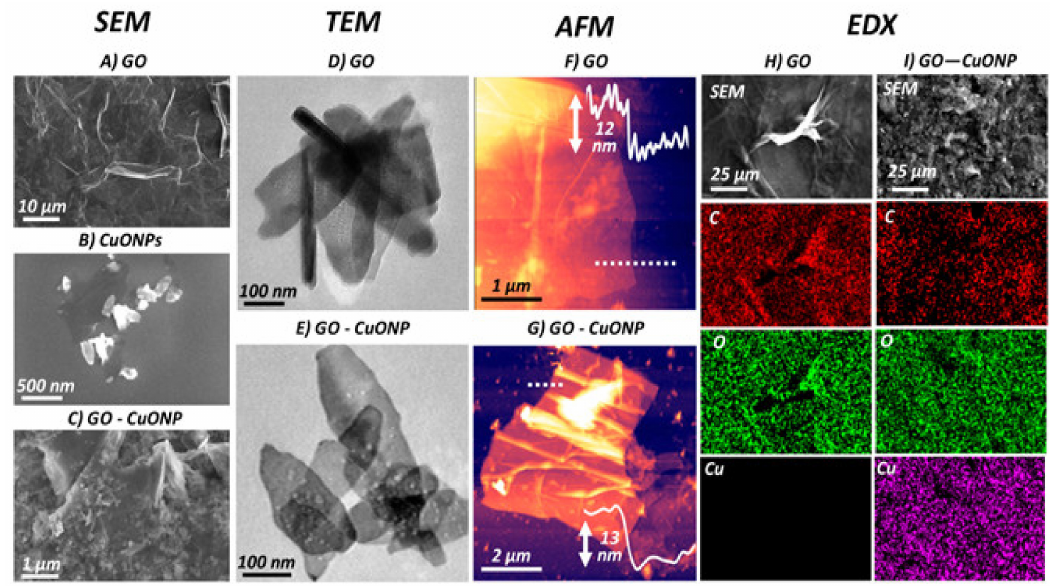
Figure 8. SEM images of ( A ) GO, ( B ) CuO nanoparticles, and ( C ) GO-CuO nanocomposite. ( D and E ) TEM and ( F and G ) AFM images of GO and GO-CuO, respectively. Energy-dispersive X-ray (EDX) spectral map for H) GO and I) GO-CuO nanocomposite. Reprinted from Ref. [72], with permission from the American Chemical Society,